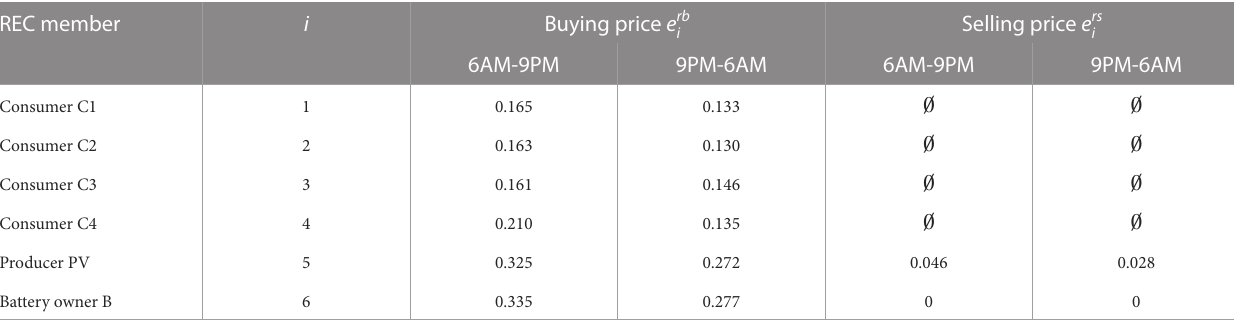
TABLE3 SyntheticpricingplansforCasesI&II.